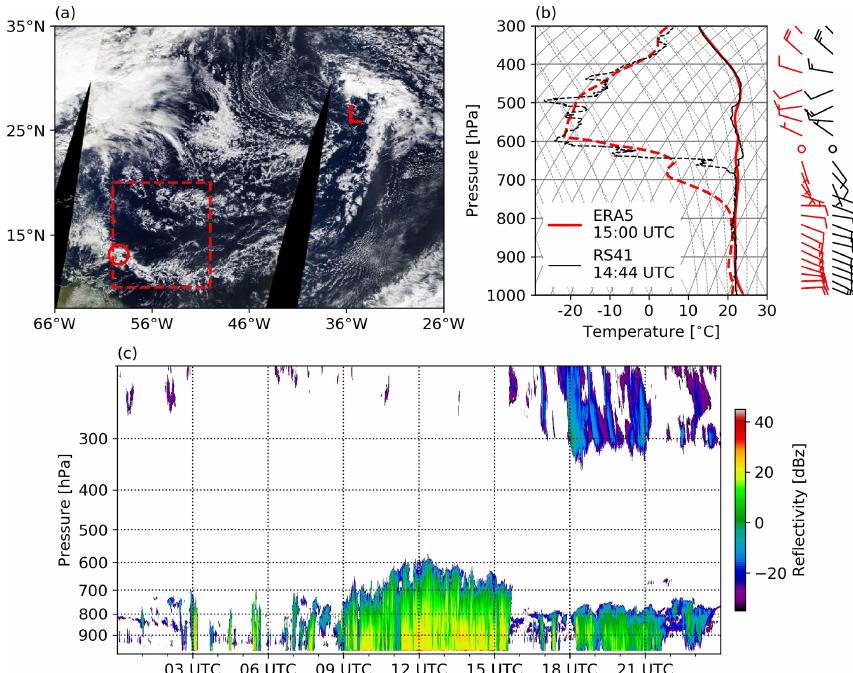
Figure 5. (a) MODIS Terra satellite image at about 14:30UTC on 22 January 2020 in the domain 8–35 ◦ N, 26–66 ◦ W, the location of Barbados (red circle), and the domain used for the domain-mean CRE calculation (10–20 ◦ N, 50–60 ◦ W; red box). (b) Vertical profiles of temperature (solid lines), dew point temperature (dashed lines), and wind (arrows) from ERA5 (thick red lines) and the atmospheric sounding (thin black lines) at about 15:00UTC on 22 January 2020. (c) Vertical profiles measured by the cloud radar (equivalent radar reflectivity of all hydrometeors) at the BCO on 22 January